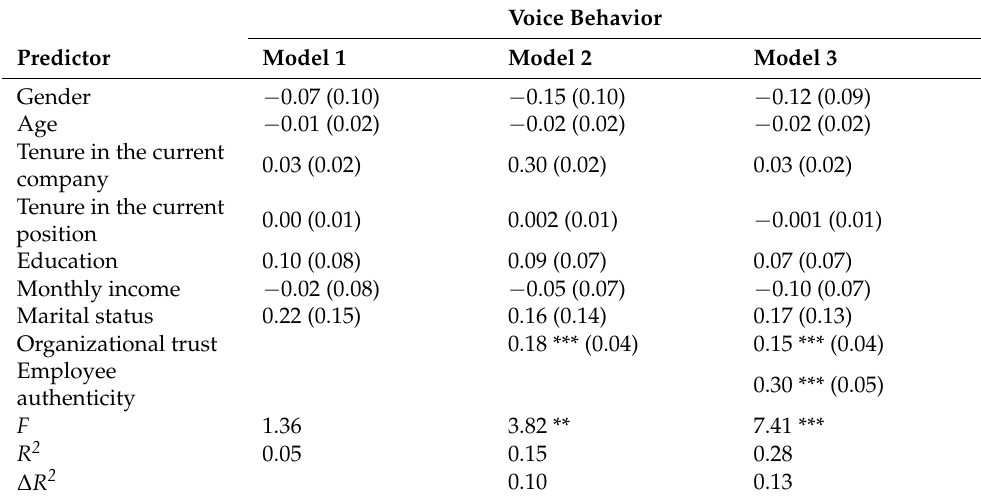
Table 4. Regressions results of voice behavior in Study 1b. Voice Behavior Model 1 Model 2 Model